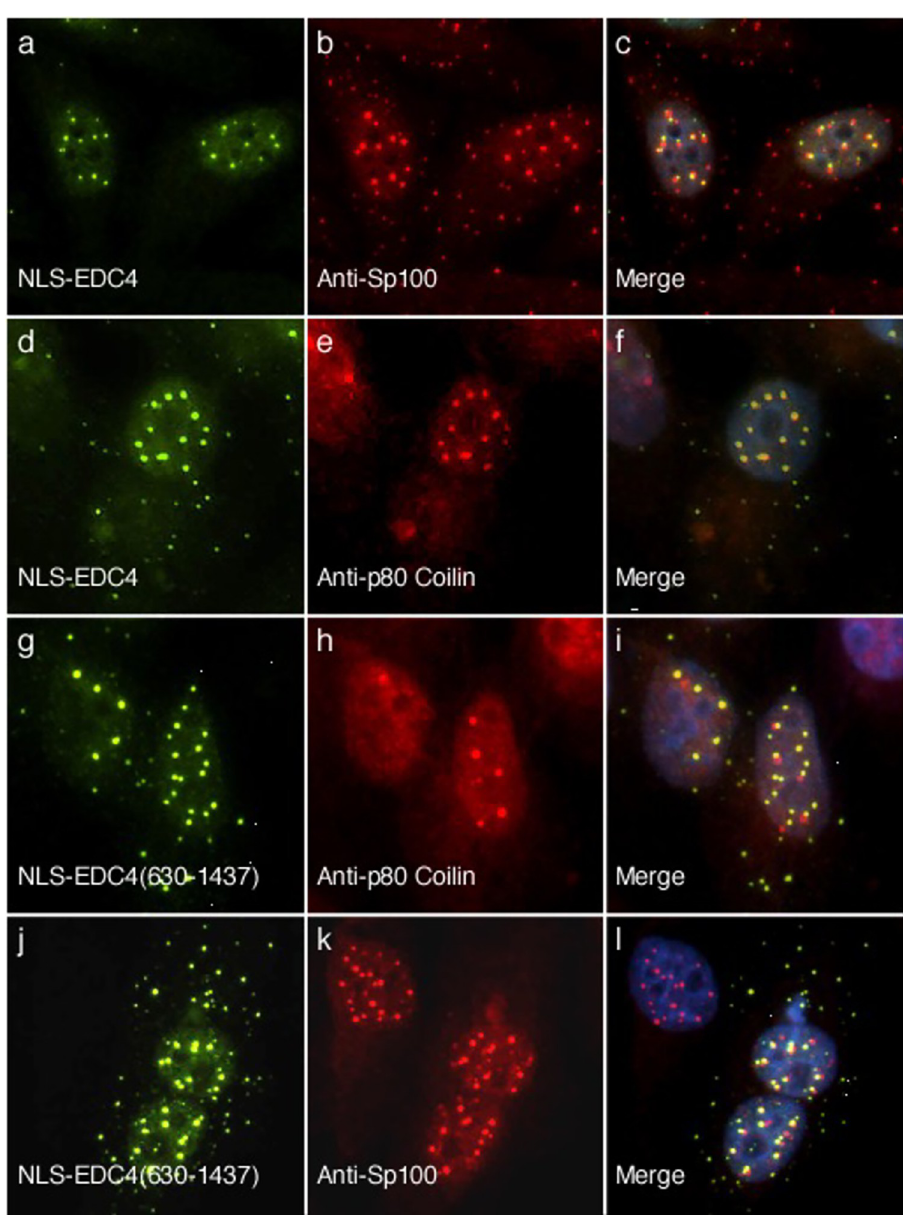
Fig 1. NLS-EDC4 localizes to Cajal bodies, and adjacent to PML-nuclear bodies. A plasmid encoding green fluorescent protein (GFP) fused to the nuclear localization sequence (NLS) of SV40 T antigen and full length EDC4 was transfected into HEp-2 cells. GFP-NLS-EDC4 (panel a) localized adjacent to PML-nuclear bodies (panels b, c). The GFP-NLS-EDC4 fusion protein was detected using mouse monoclonal anti-GFP antibodies and PML nuclear bodies were identified using rabbit anti-Sp100 antiserum. Transfection of GFP-NLS-EDC4 and subsequent staining with mouse anti-GFP antibodies and rabbit anti-p80 coilin antibodies revealed that NLS-EDC4 (panel d) localized to Cajal bodies (panels e, f). Transfection of HEp-2 cells with a plasmid encoding GFP-NLS-EDC4(630–1437) (panel g) and subsequent staining with mouse anti-GFP antibodies and human serum containing anti-p80 coilin antibodies (panels h, i), revealed that in the absence of the N-terminus, EDC4 was no longer able to localize to Cajal bodies. GFP-NLS-EDC4(630–1437) (panel j) retained the ability to localize adjacent to PML nuclear bodies (panels k, l). Merge of panels a and b, d and e, g and h, and j and k is shown in panels c, f, i, and l respectively. DAPI staining (blue) indicates the location of nuclei in c, f, i and l.